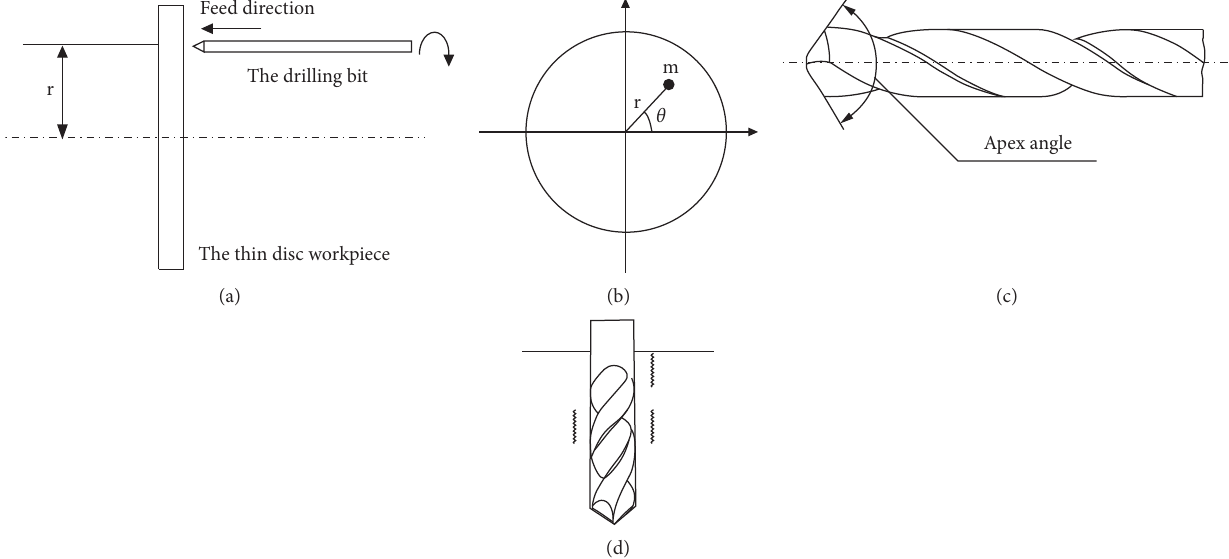
Figure 1: The physical models of drilling hole way: (a) the weight removing principle by drilling hole way; (b) the weight removing position; (c) the tool structure; (d) the cutting